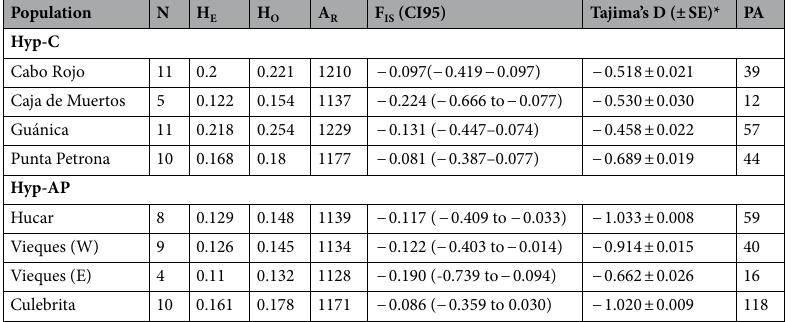
Table 1. Summary statistics of genetic diversity for both Hypogeococcus species invading Puerto Rico (Hyp-C and Hyp-AP). N: sample size; H E : expected heterozygosity; H O : observed heterozygosity; A R : allelic richness; F IS : inbreeding coefficient, P A : private